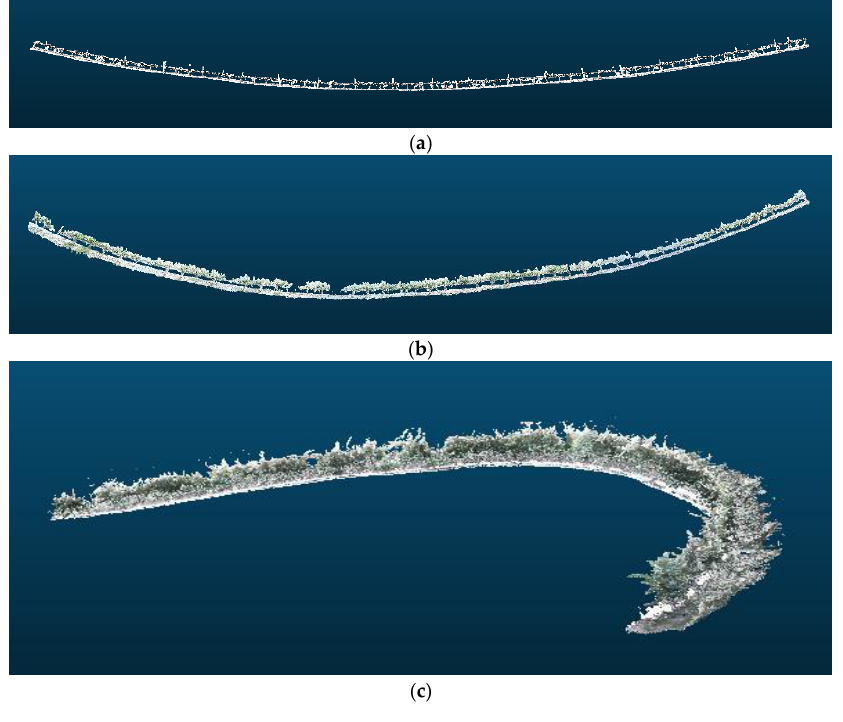
Figure 16. Examples of 3D reconstructions that exhibit drift. Sampling performed in: ( a ) February 2016; ( b ) May 2016; and ( c ) July 2016.